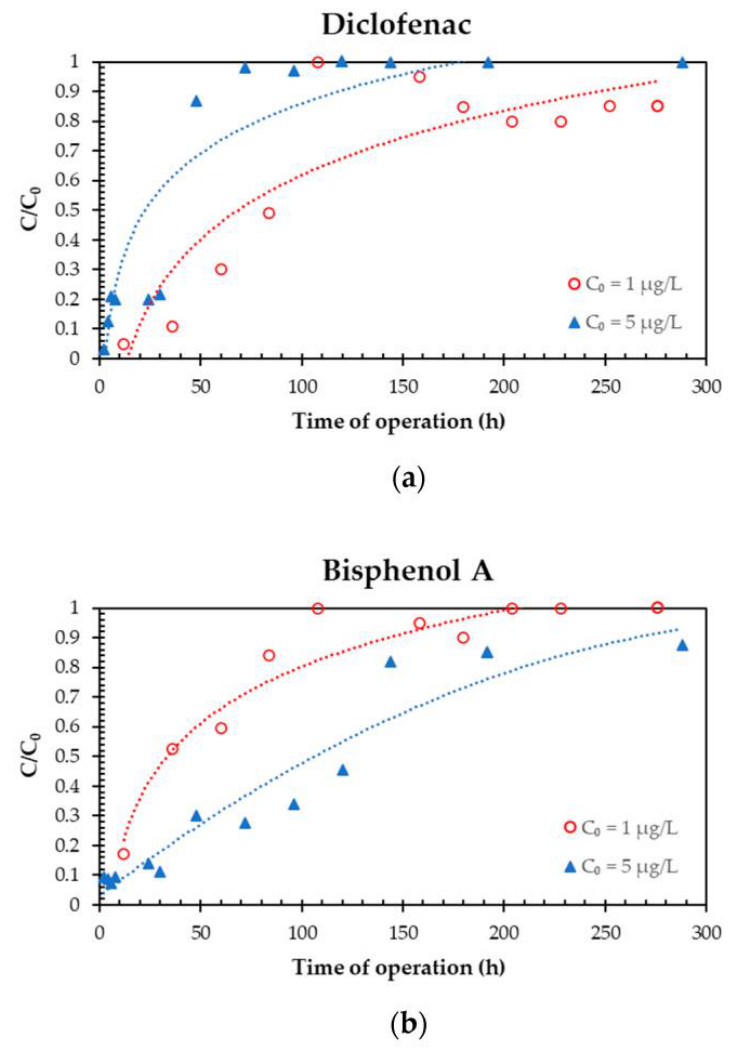
Figure 2. Effect of initial concentration on the removal efficiency of diclofenac ( a ) and bisphenol A ( b ) (Q = 26 L/d, CT = 8.8 min, no pH